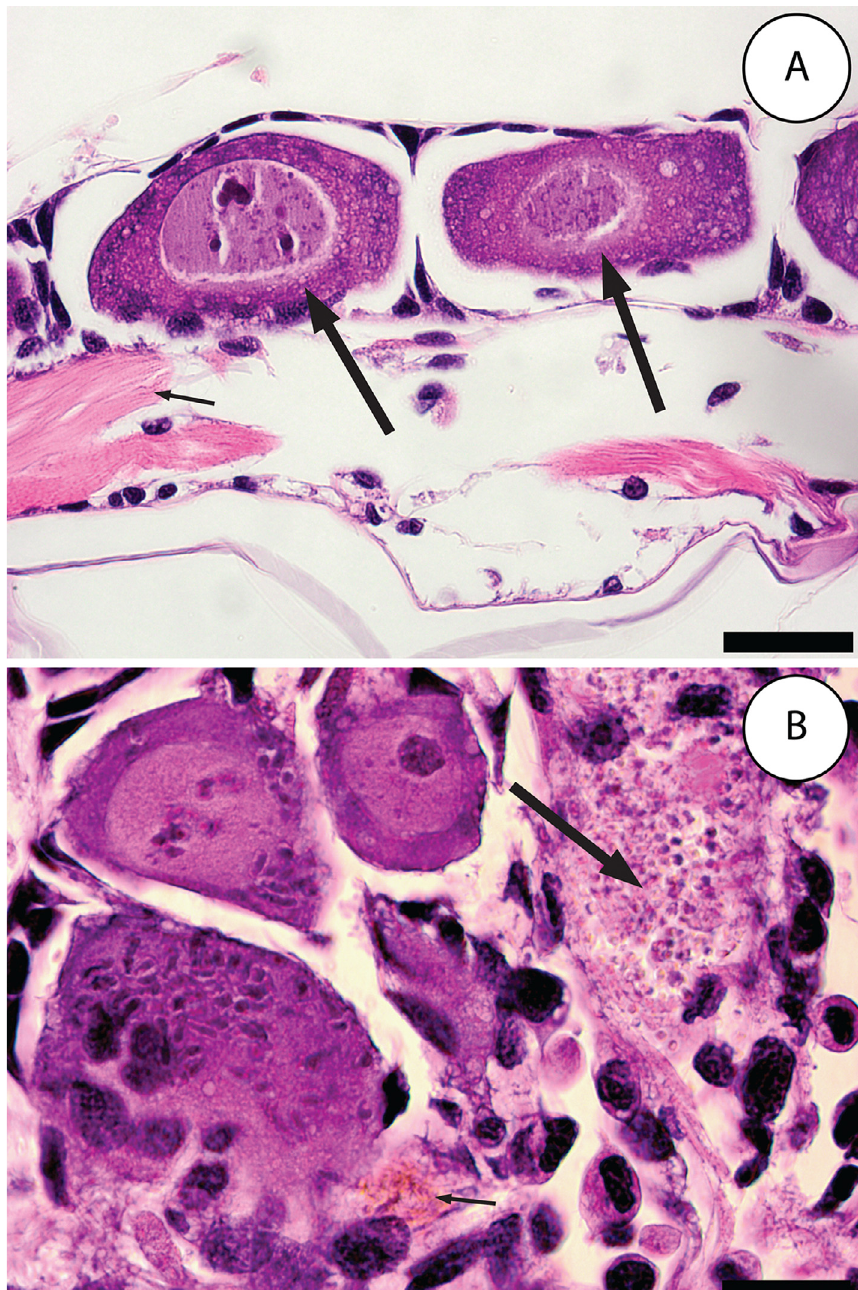
Figure 4. Histological sections (hematoxylin and eosin) of Diporeia (Amphipoda) collected from Lake Superior. Notice (A) the histologically normal ovaries (large arrows) of an amphipod not displaying a microsporidian infection in the muscle tissue (small arrow) and (B) melanized hemocytic encapsulation near the ovaries (small arrow) of an amphipod displaying a microsporidian infection ( Dictyocoela diporeiae n. sp.) in the muscle tissue (large arrow). Scale bar = 25 l